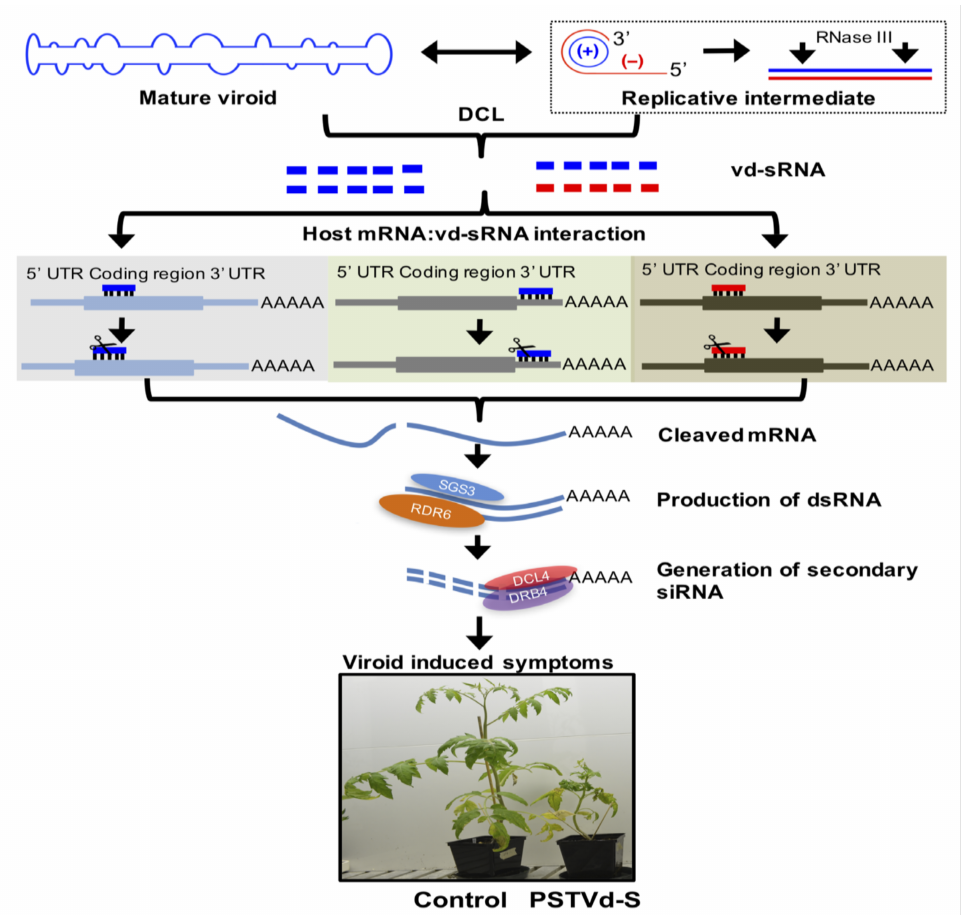
Figure 4. Mechanism of viroid symptom induction. (Adapted from Adkar-Purushotama and Perreault, 2019